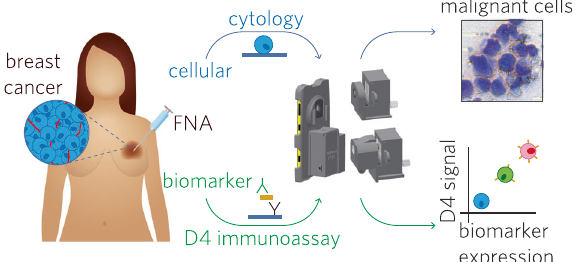
Fig. 1 Schematic representation of the EpiView-D4 mobile pathology platform for breast cancer. The device has a smart- phone base which uses detachable modules for bright fi eld (top) and fl uorescence (bottom) imaging using the cell phone camera. Tumor is fi rst sampled by FNA, and then aspirates are processed for cytology and biomarker evaluation. For cytology, aspirates are smeared on a glass slide and processed with rapid (DiffQuik TM ) staining kits and then imaged with the bright fi eld imaging attachment (top). For biomarker evaluation, aspirates are mixed with lysis buffer and then applied to a D4 immunoassay chip, which quantify an analyte of interest (in this case, HER2). D4 chips are read using the fl uorescence imaging attachment. The fl uorescence intensity of the cAb spots on the D4 chip correlates with the biomarker expression